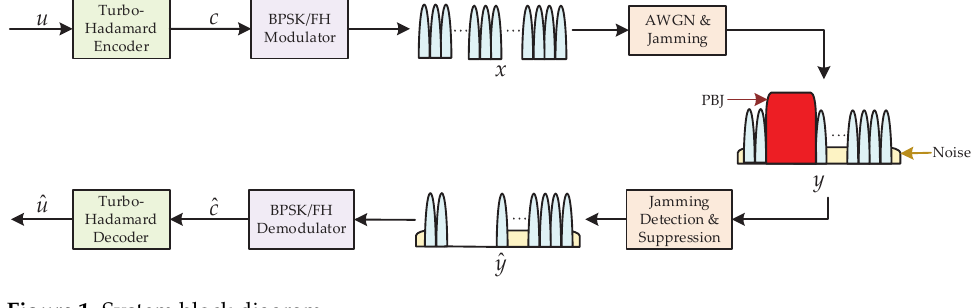
Figure 1. System block